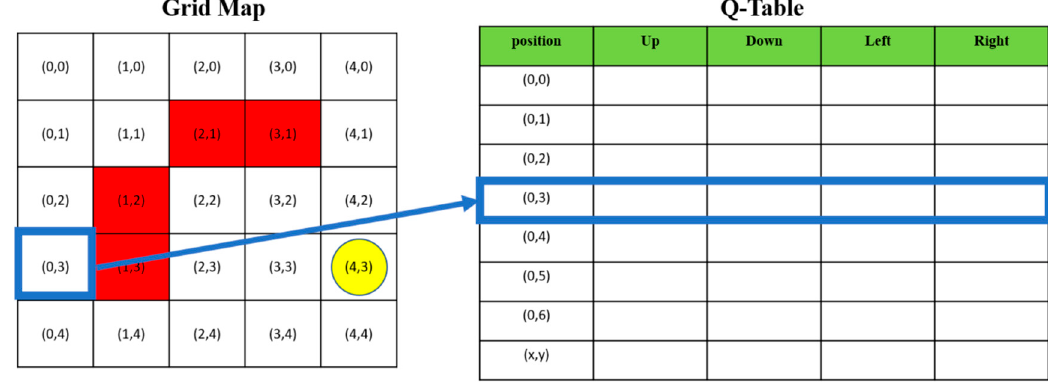
Figure 13. Grid map stored in a Q-table.